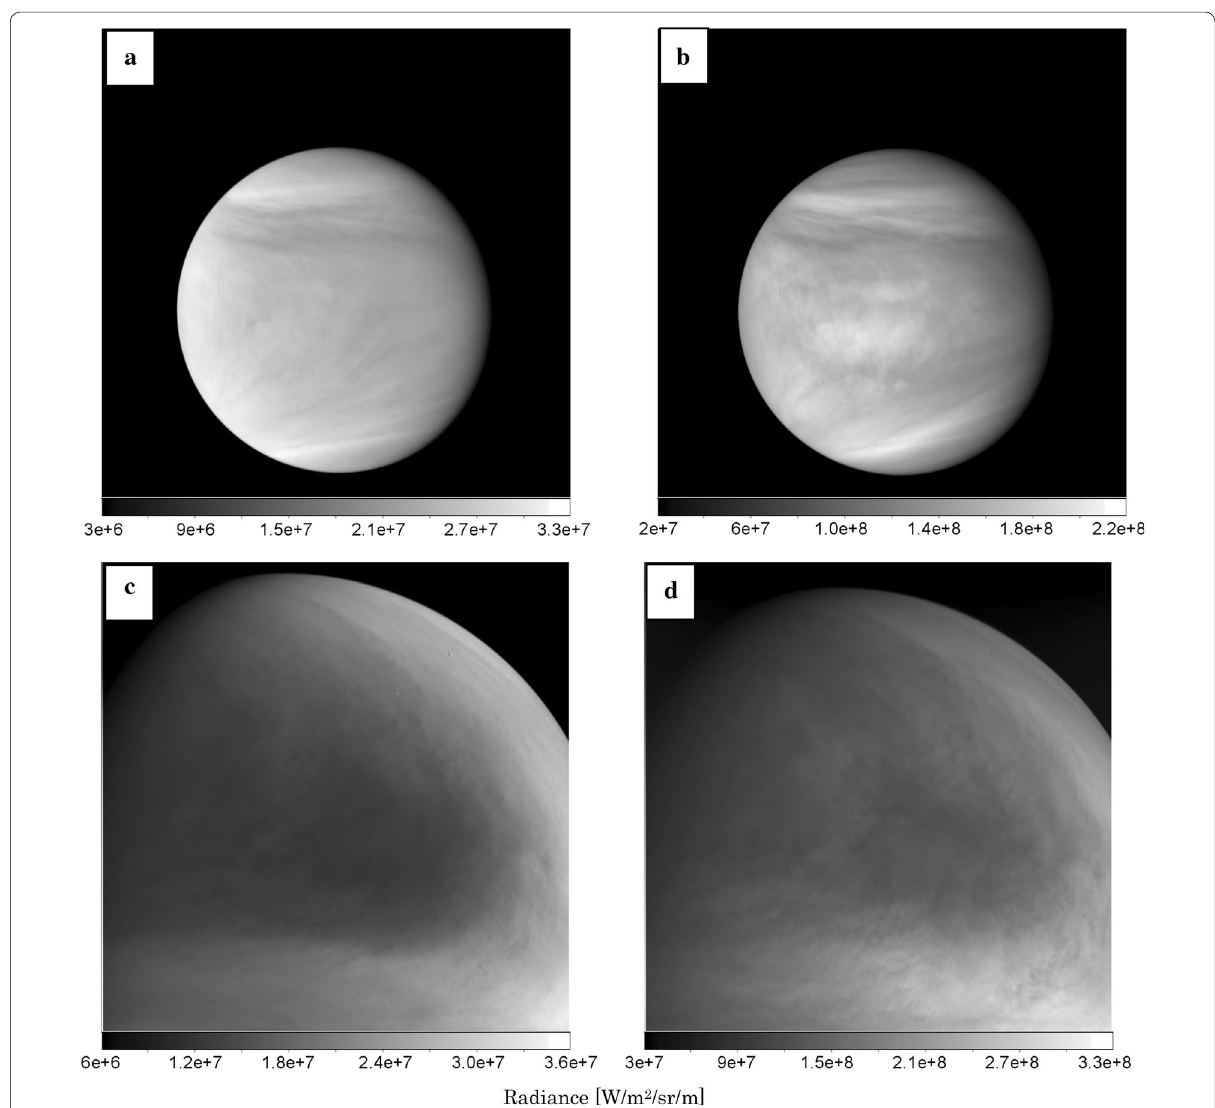
Fig. 9 Examples of UVI 283‑nm images ( a , c ) and 365‑nm images ( b , d